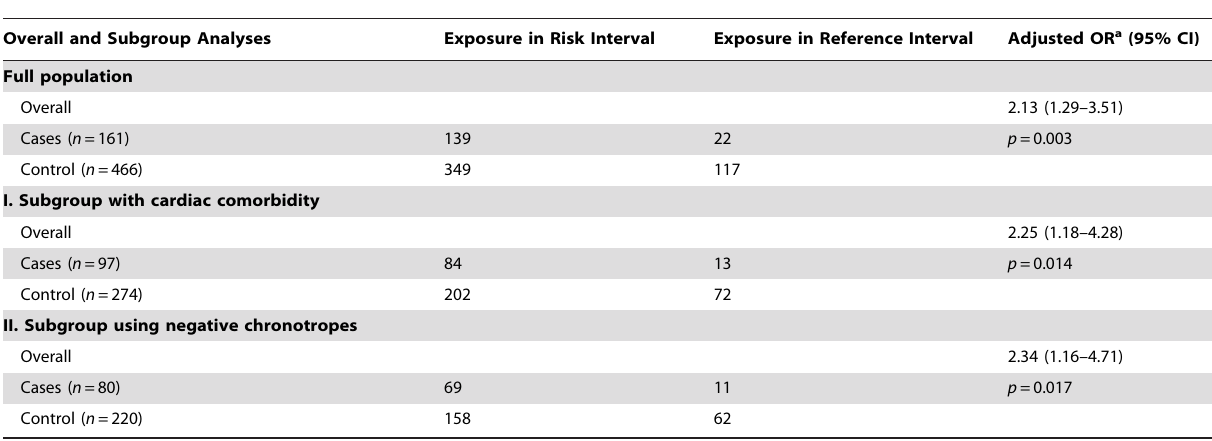
Table 2. Risk of bradycardia-related hospital admissions and recent cholinesterase inhibitor use.